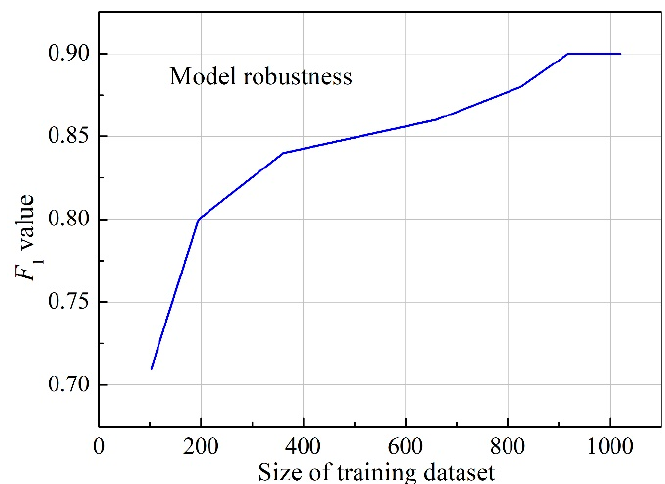
Figure 3. F 1 values of models based on different training size.